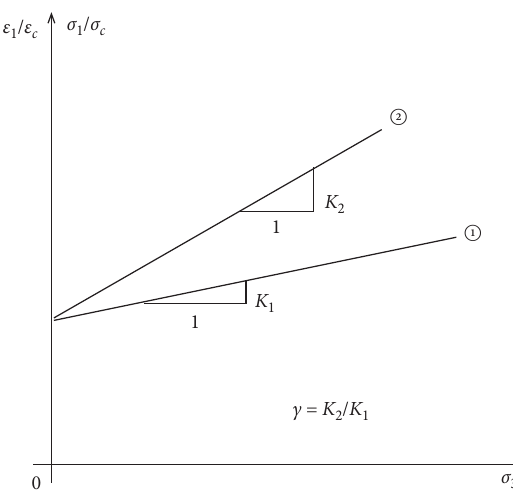
Figure 5: Sketch of stress and strain strength proportional ratio. (a) Stress intensity curve. (b) Strain intensity curve.